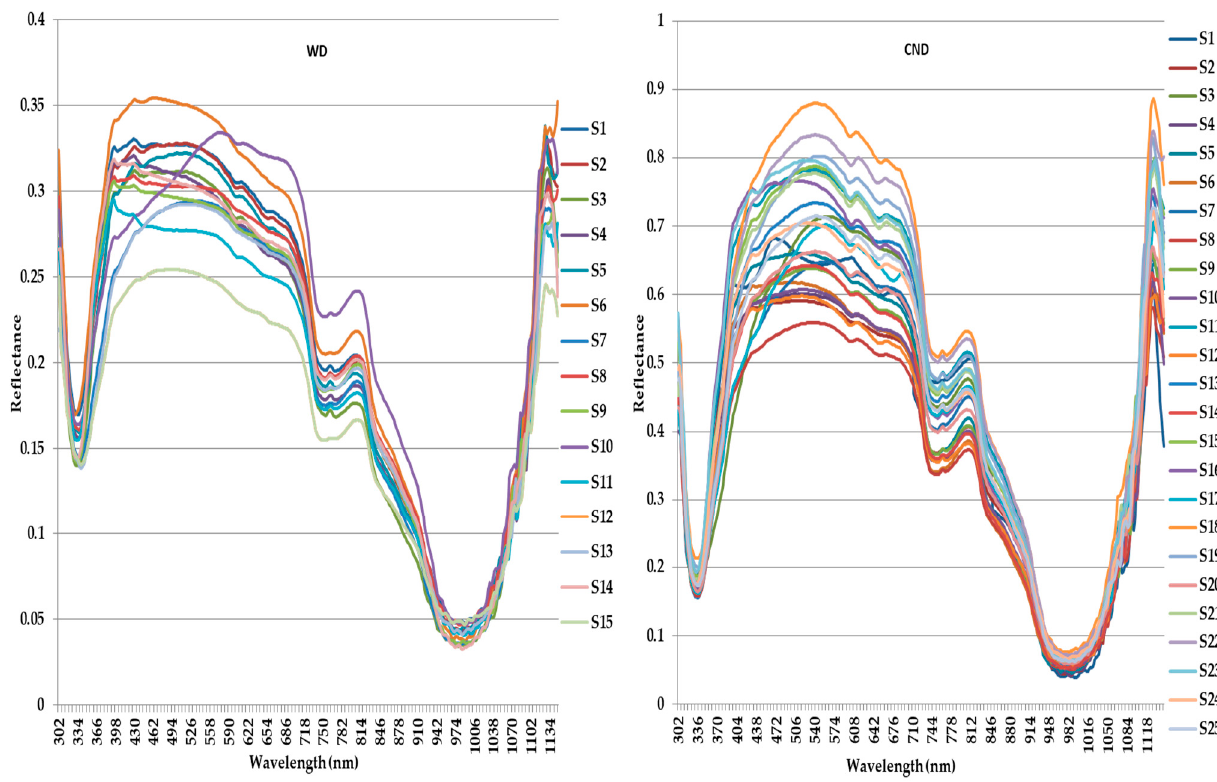
Figure 6. Spectral reflectance signature of the different groundwater samples collected from the Western Desert (WD) and Central Nile Delta (CND).